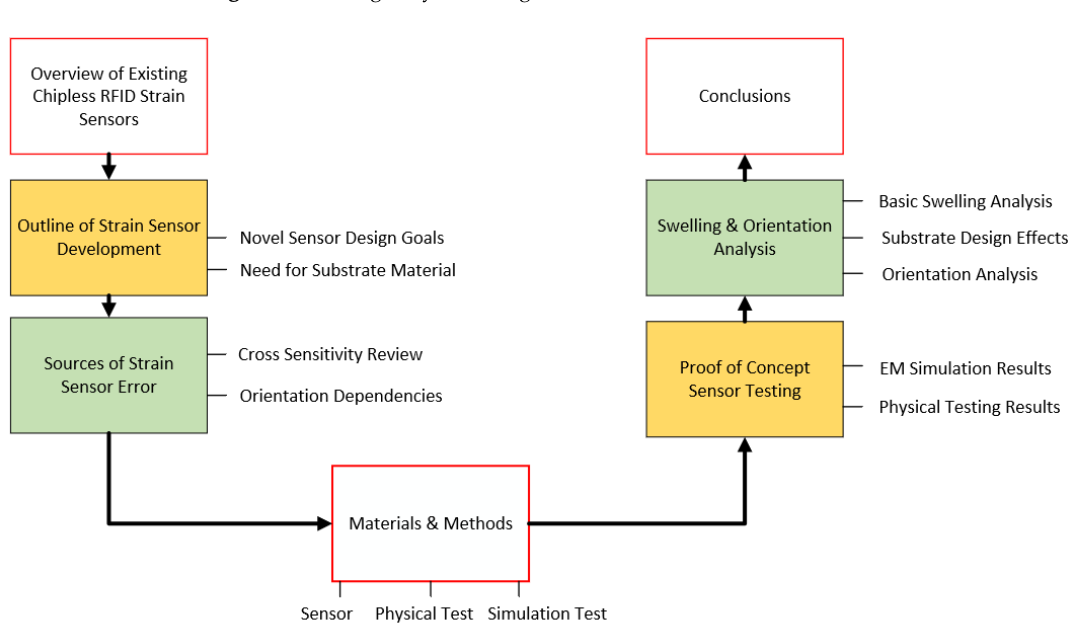
Figure 1. Envisaged system diagram.